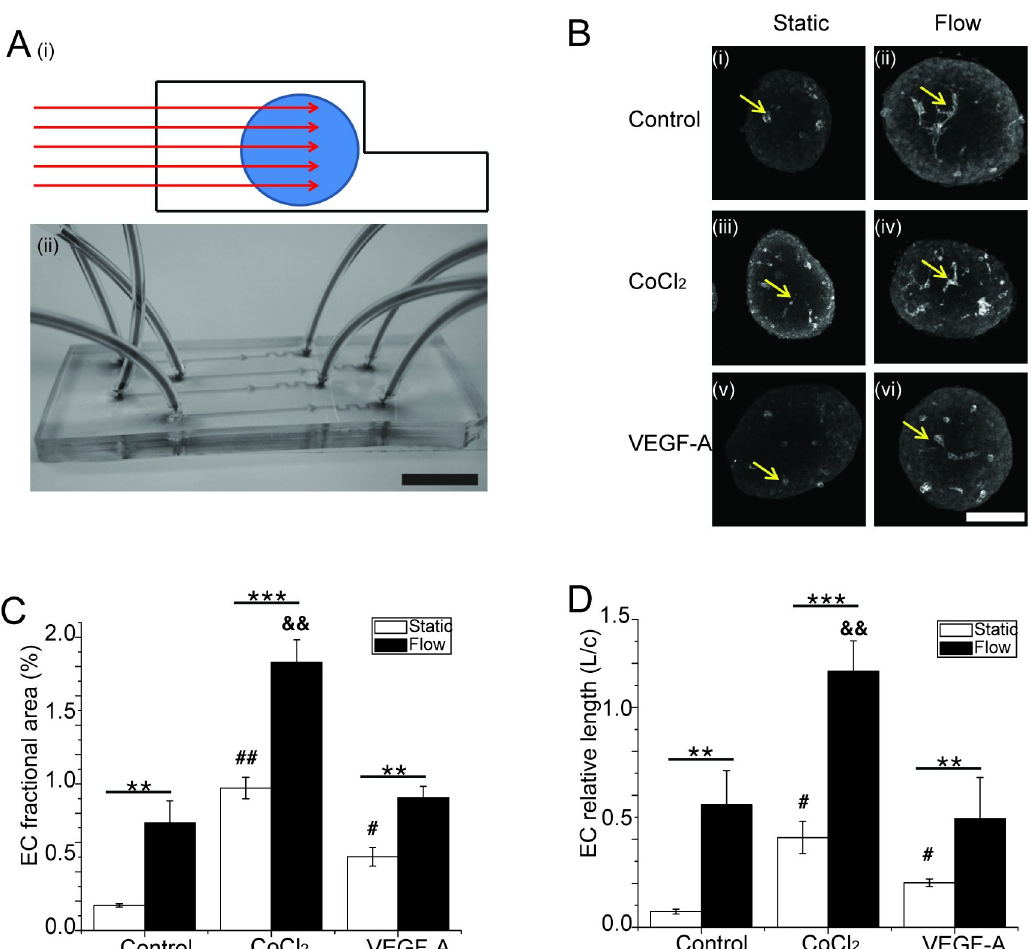
Fig 4. Effect of CoCl 2 , microfluidic flow, and exogenous VEGF-A on EC morphology. (A) (i) Schematic and (ii) image of a microfluidic device used to culture pancreatic islets in flowing media. This device holds islets in a dam-wall to subsequently induce the flow of media both around and through the tissue (direction of flow shown in (A)(i) schematic). The device was filled with food coloring to illustrate the inlet and outlet tubing and 100 μ m tall channels. Each device has 4 channels, which allowed simultaneous culture of the islets in control (0 μ M CoCl 2 ), 100 μ M CoCl 2 , and 100 ng/ml VEGF-A (scale bar = 10mm). (B)(i-vi) Representative extended focus projection images of islets cultured under static and flow conditions and treated with the previously mentioned factors. The islets were subsequently immunofluorescently labeled for PECAM-1 to illustrate the ECs (shown by arrows) (scale bar = 50 μ m). (C & D) The image stacks from (B) were quantified to determine the EC fractional area (C) and EC relative length (D) for each islet; (n = 6 mice on separate days). Statistical significance was determined by one-way ANOVA with post-hoc Bonferroni test. Error bars are ± SEM; �� , p < 0.01; ��� , p < 0.001. #, p < 0.01 compared to static control; ##, p < 0.001 compared to static control. &&, p < 0.001 compared to flow control.